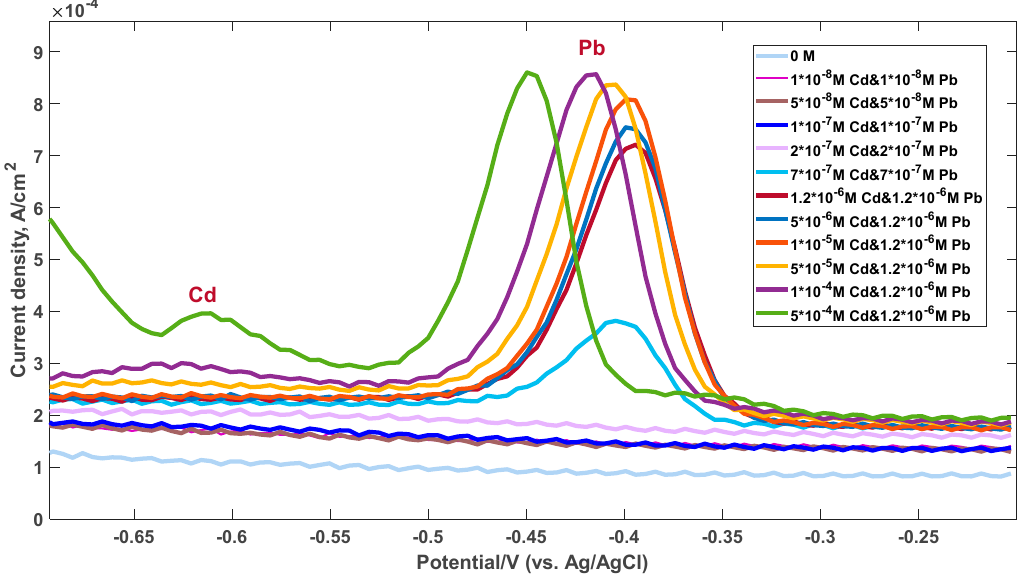
Figure 5. Square wave anodic stripping voltammetry (SWASV) electrochemical response of the graphene electrode for the simultaneous analysis of Cd 2+ and Pb 2+ .